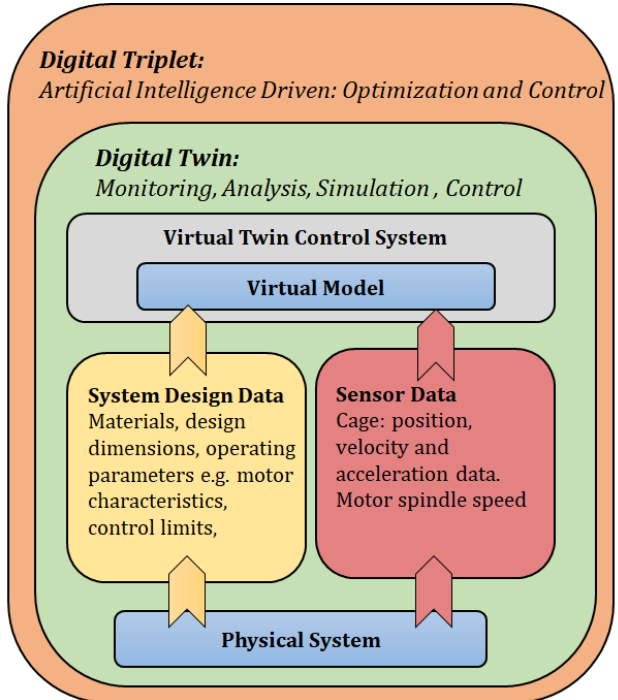
Figure 4. Block diagram of the key components and interactions of a typical Digital Triplet